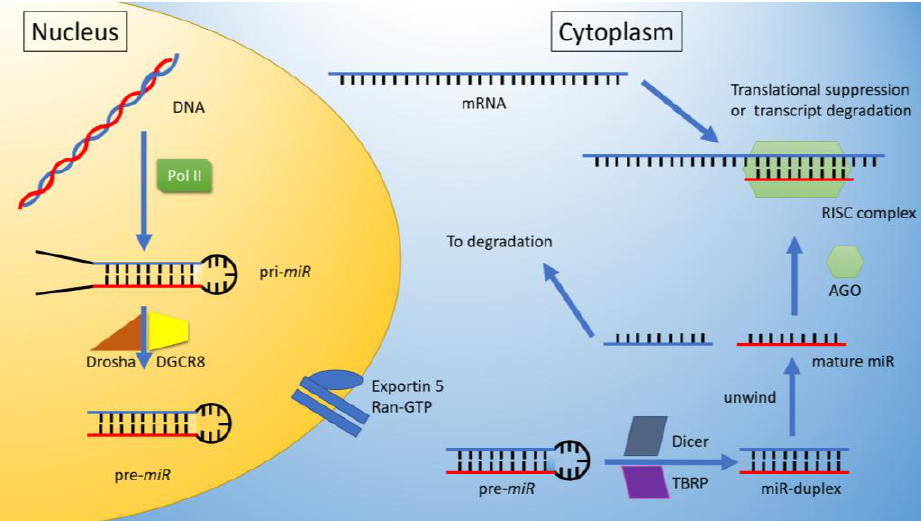
Figure 1. mRNA biogenesis. Transcription of a pri- miR by pol II, followed by cleavage (Drosha/DGCR8 complex) to a pre- miR . The pre- miR is later exported to the cytoplasm via exportin-5/Ran-GTP, where it can be further cleaved by a Dicer/TRBP complex and unwind into its mature form. This is further packed by AGO into the RNA-induced Silencing Complex (RiSC) with mRNA. The consequence of such loading is either a transcriptional suppression or transcript degradation.